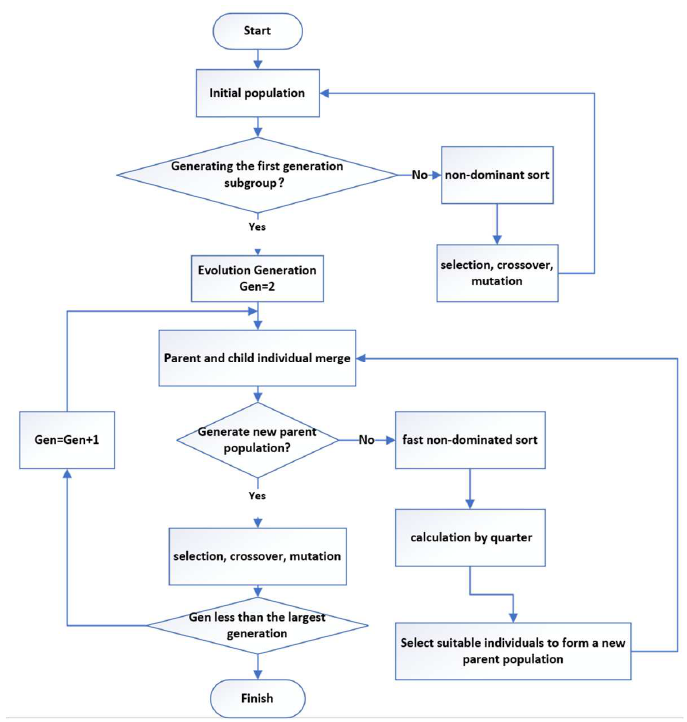
Figure 1. Flow chart of NSGA-II